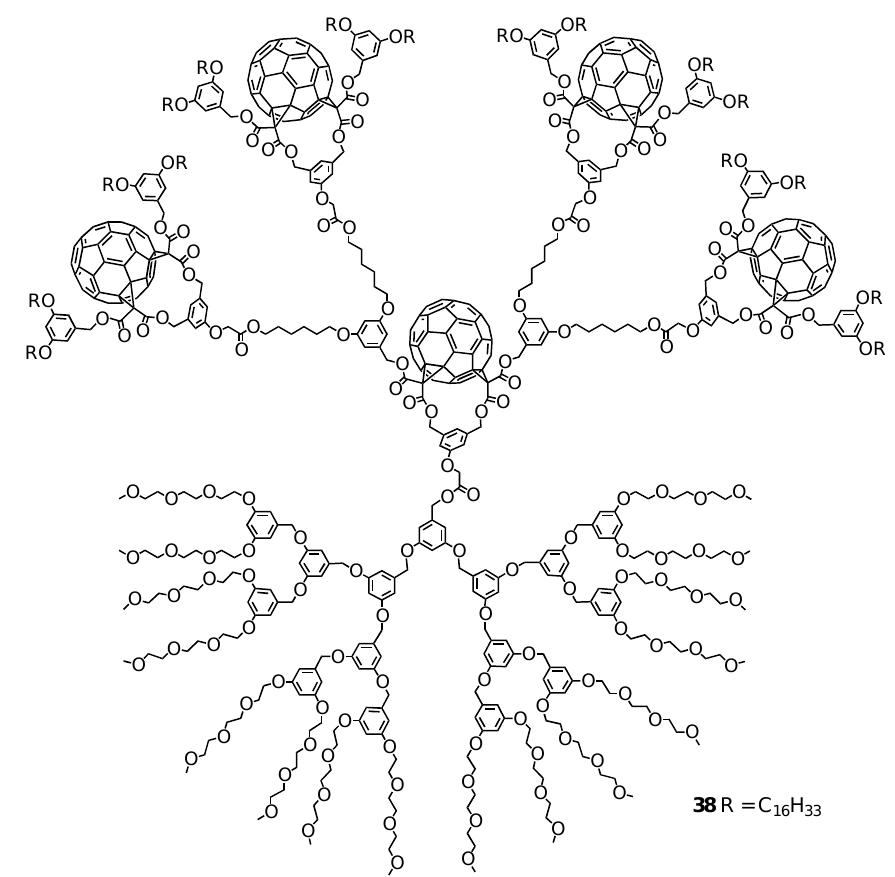
Figure 3. Structure of amphiphilic fullerodendrimer 38